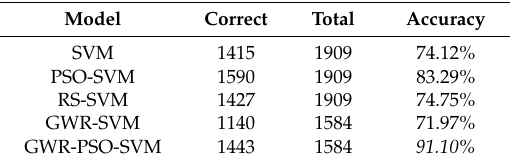
Table 10. Overall accuracies by all the prediction models.